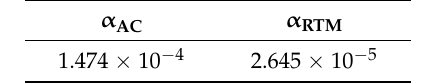
Table 6. Comparison between asphalt concrete (AC) and RTM temperature